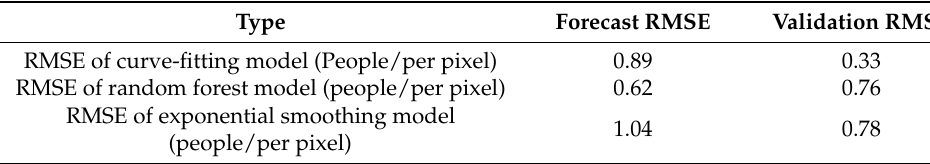
Table 3. Comparison of the accuracy of three methods. Type Forecast RMSE Validation RMSE RMSE of curve-fitting model (People/per pixel) 0.89 0.33 RMSE of random forest model (people/per pixel) 0.62 0.76 RMSE of exponential smoothing model 1.04 (people/per pixel)